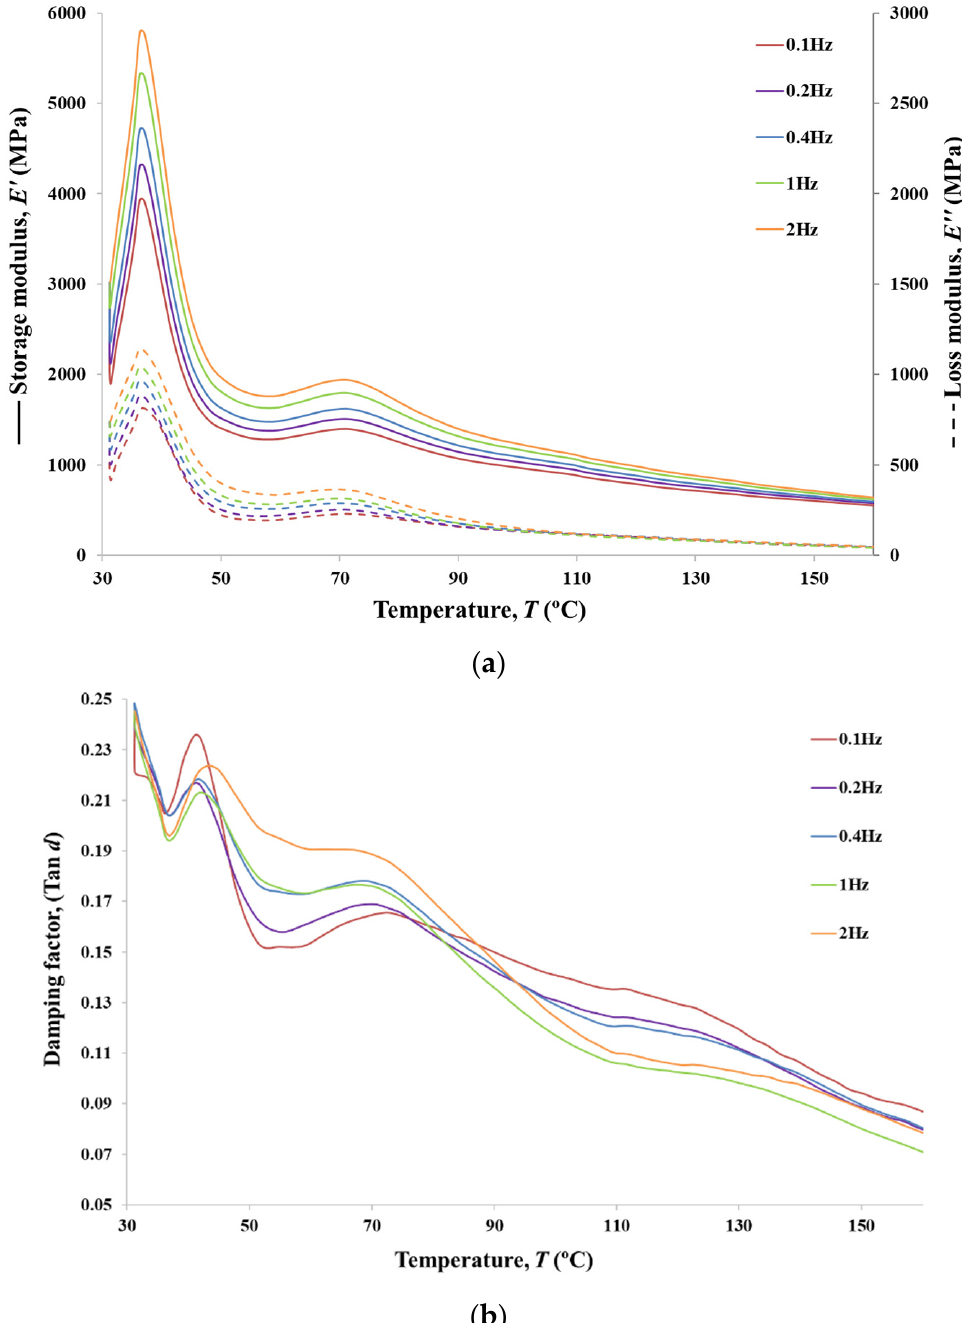
Figure 14. Storage and loss moduli ( a ), and tangent loss ( b ) for PVA 6BY.